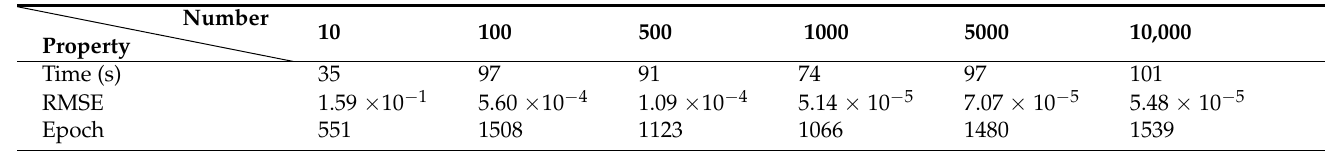
Table 4. The training time (s) and prediction error RMSEs, and the number of epochs for various amount of samples used in the